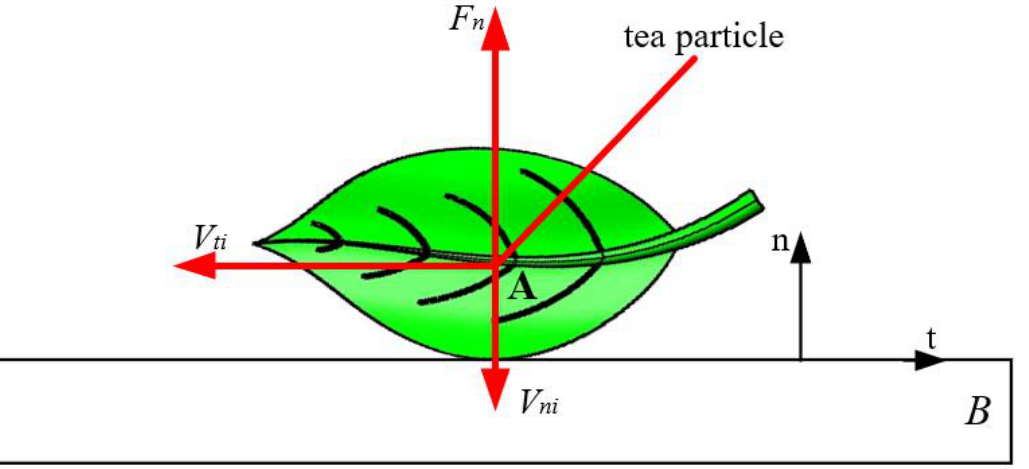
Figure 4. Force analysis diagram of tea particles colliding with the inner wall of the pot slot.